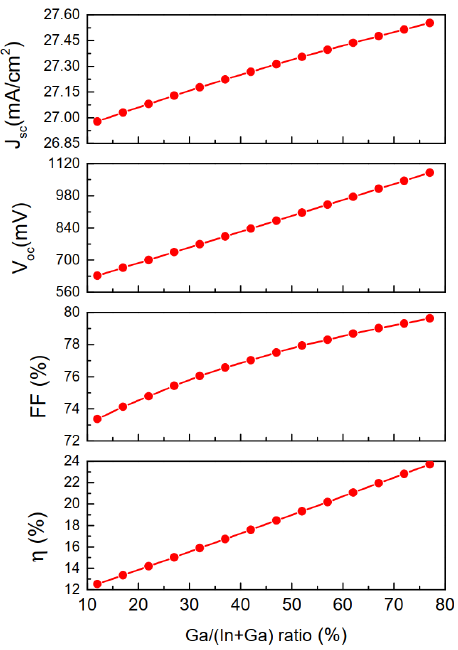
Figure 14. Cell parameters for different Ga/(In+Ga) ratios.